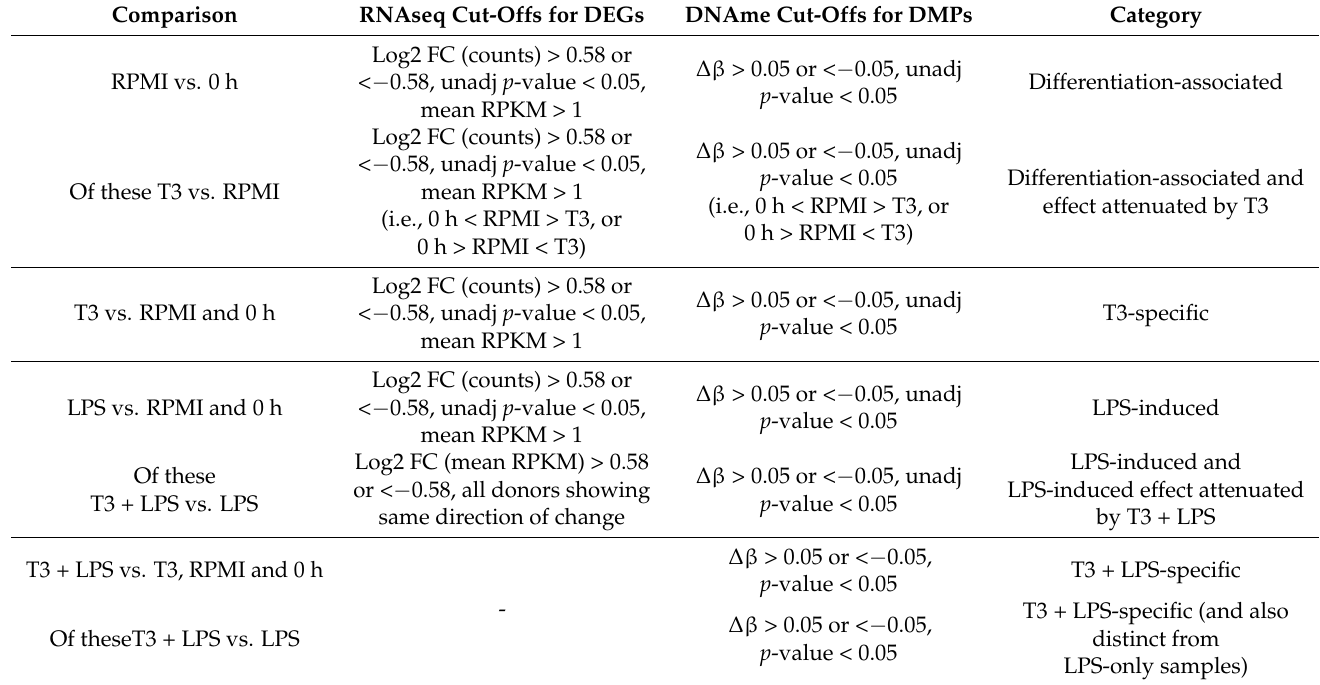
Table 1. Details of RNAseq and DNA methylation (DNAme) cut-offs for identifying DEGs and DMPs. Comparison